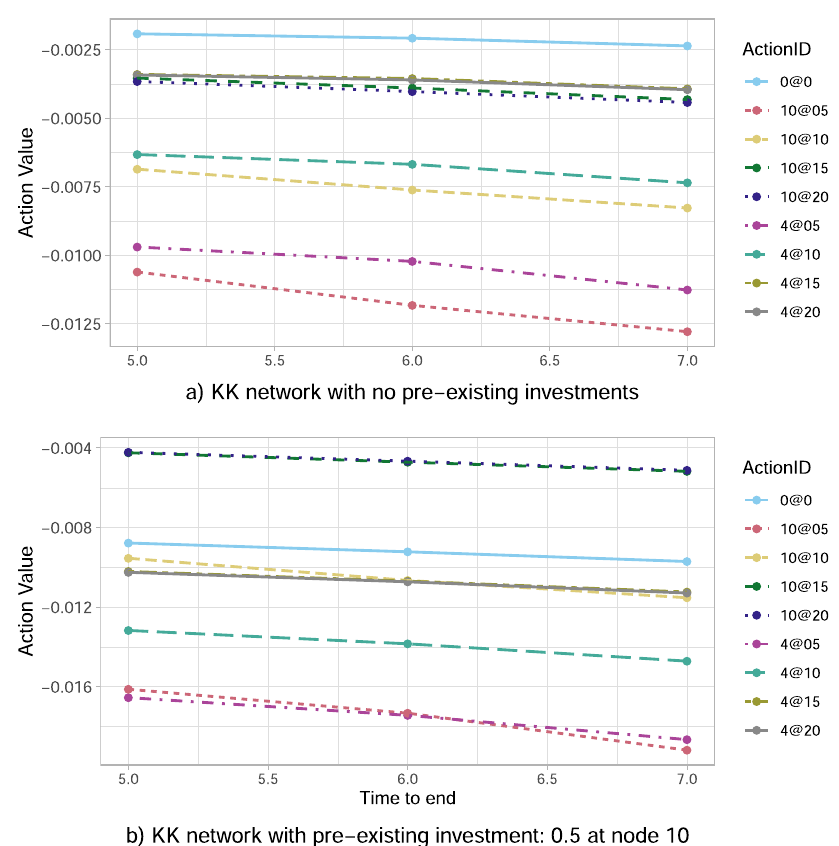
Fig. 3 | Optimal action value function Q * for the Krackhardt Kite (KK) network as a function of time to the end of crisis. The results are obtained for the per- centage α =0.0001ofwealthlossupondefault,andfocusonnodes4(centralnode) and 10 (peripheral node). In the legend, the ActionID 0@0 means no investment, 0@05means investing 0.5 in all the nodes, 10@05means investing 0.5 in node 10,